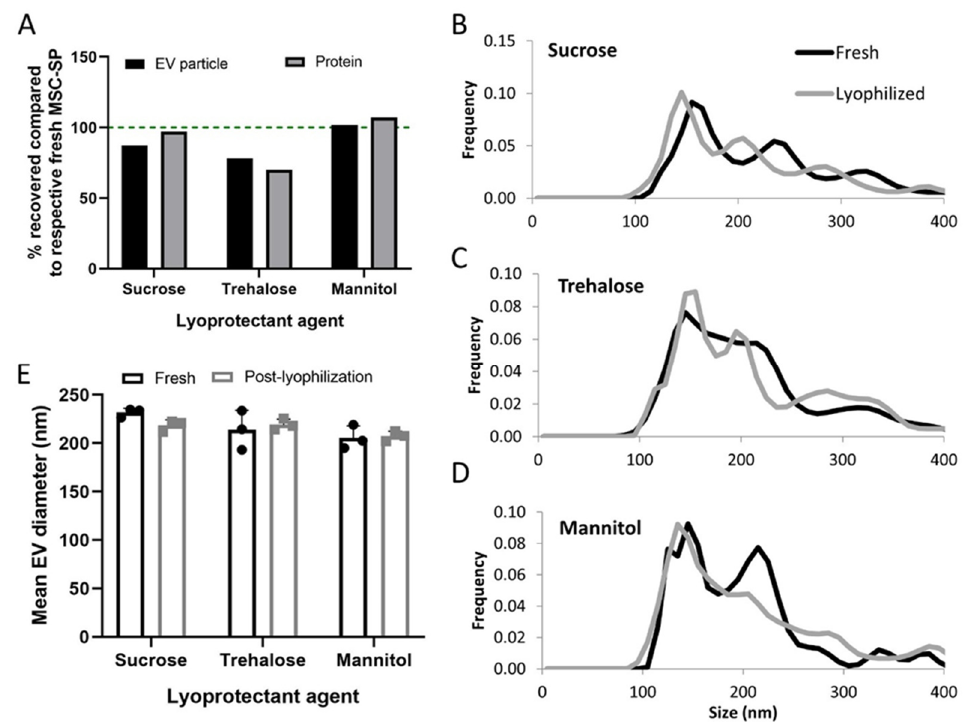
Figure 4. Characterization of the structural properties of MSC-SP lyophilized using the shelf-based protocol. MSC-SP were lyophilized using a shelf-based protocol and the EV and protein constituents were quantified by nanoparticle tracking analysis (NTA) and BCA assay, respectively. The ( A ) EV and protein recoveries of the lyophilized MSC-SP were calculated. ( B – D ) The size distribution profiles and the ( E ) mean diameters of the EV within the fresh and lyophilized MSC-SP were quantified using NTA. Table 2. Size distribution profile of EV present in fresh and lyophilized MSC-SP samples.